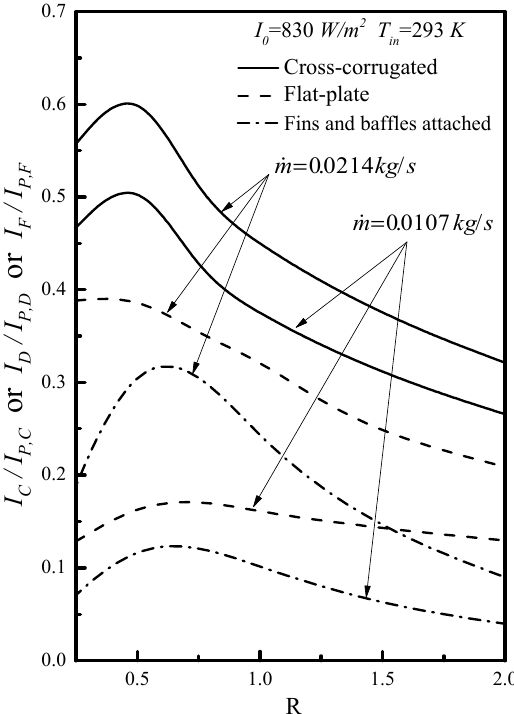
Figure 8. The values of I C /I P,C , I D /I P,D and I F /I P,F vs. R and ṁ as a parameter.